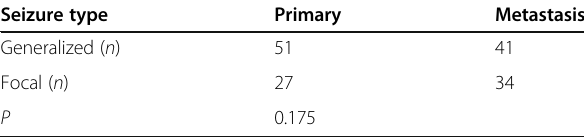
Table 3 Correlations of seizure type with tumor type Seizure type